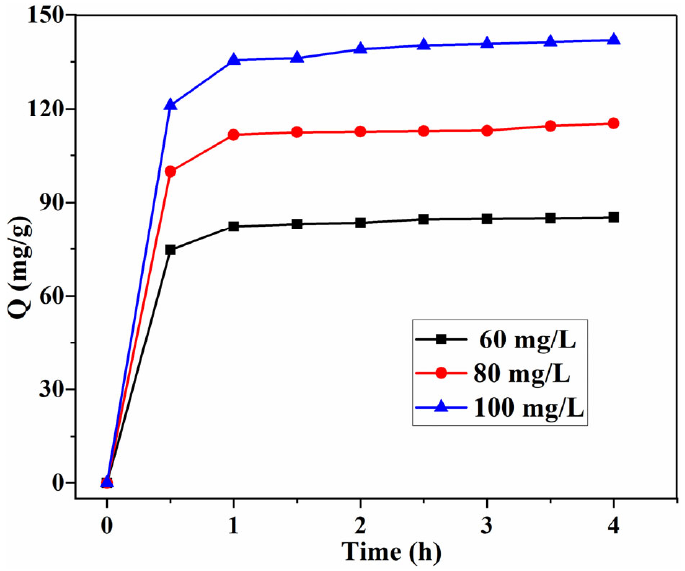
Figure 9. Effect of initial concentration and contact time on the adsorption capacity Q (mg/g) with 40%Tan/SA beads (pH = 12, T = 45 °C).